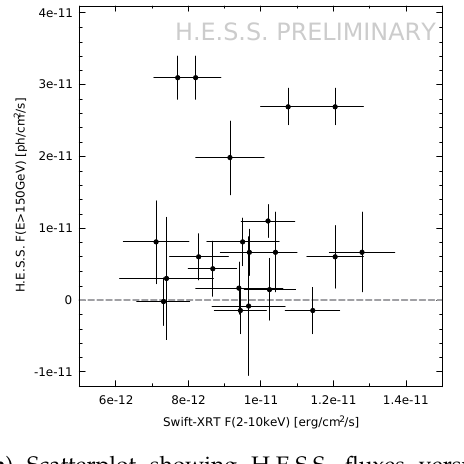
( a ) Scatterplot showing H.E.S.S. fluxes versus ( b ) Scatterplot showing H.E.S.S. fluxes versus Swift -XRT fluxes. The black dashed line marks the ATOM/R fluxes. The black dashed line marks the zero-flux level for the VHE band. zero-flux level for the VHE band. Figure 4. Scatterplots for simultaneous data for